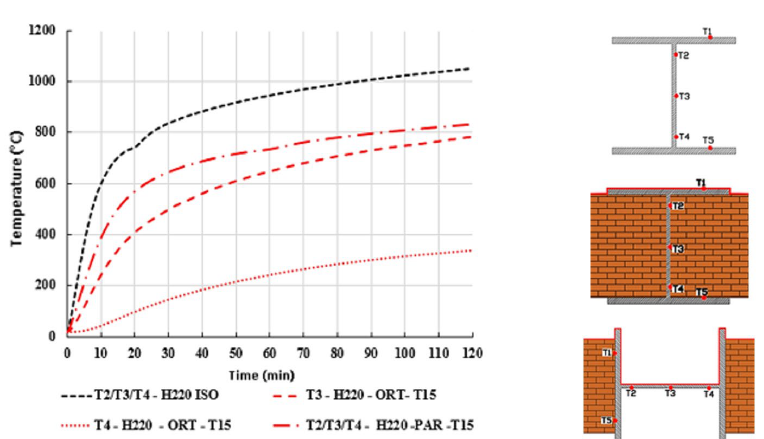
Figure 8. Curve referring to temperature as a function of time for isolated steel columns and steel columns inserted into walls, in contact with the flanges or with the